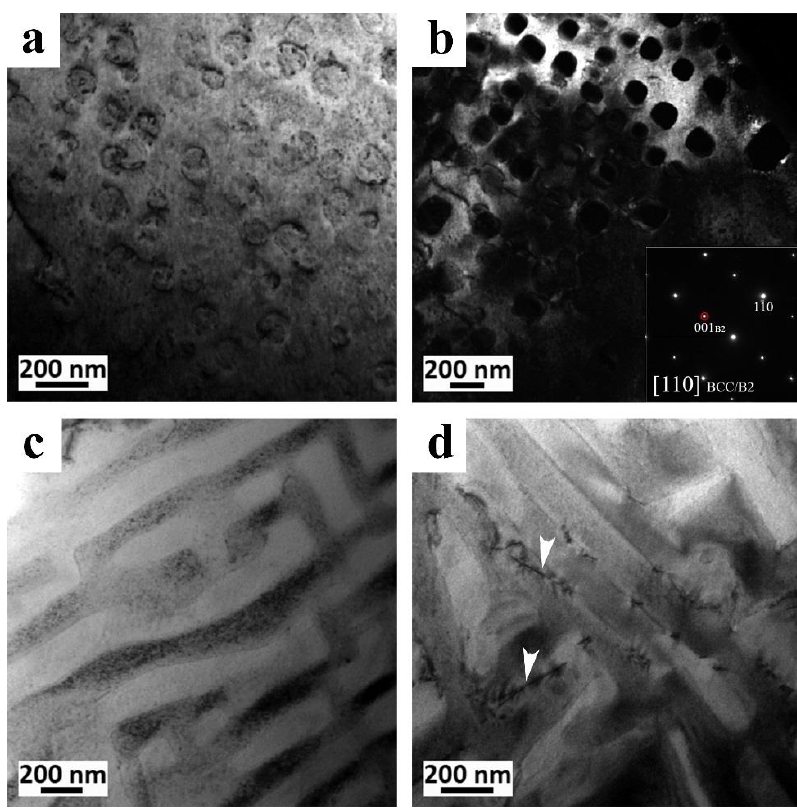
Figure 6. ( a ) BF and ( b ) DF (taken in g = (001) B2 ) TEM images of the DR area of the AlCoCrNi (w/o Fe) alloy. SAED pattern along [110] orientation is shown in the inset. B2 phase is the matrix here since it lit in the DF image. Microstructure of the ID area of the AlCoCrNi (w/o Fe) alloy is shown in ( c ) and ( d ). Dislocations are marked by arrowheads.